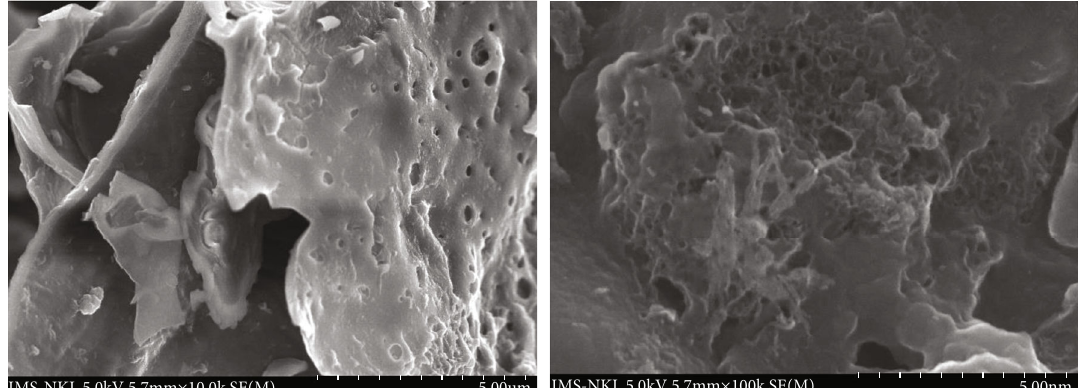
Figure 7: SEM images of